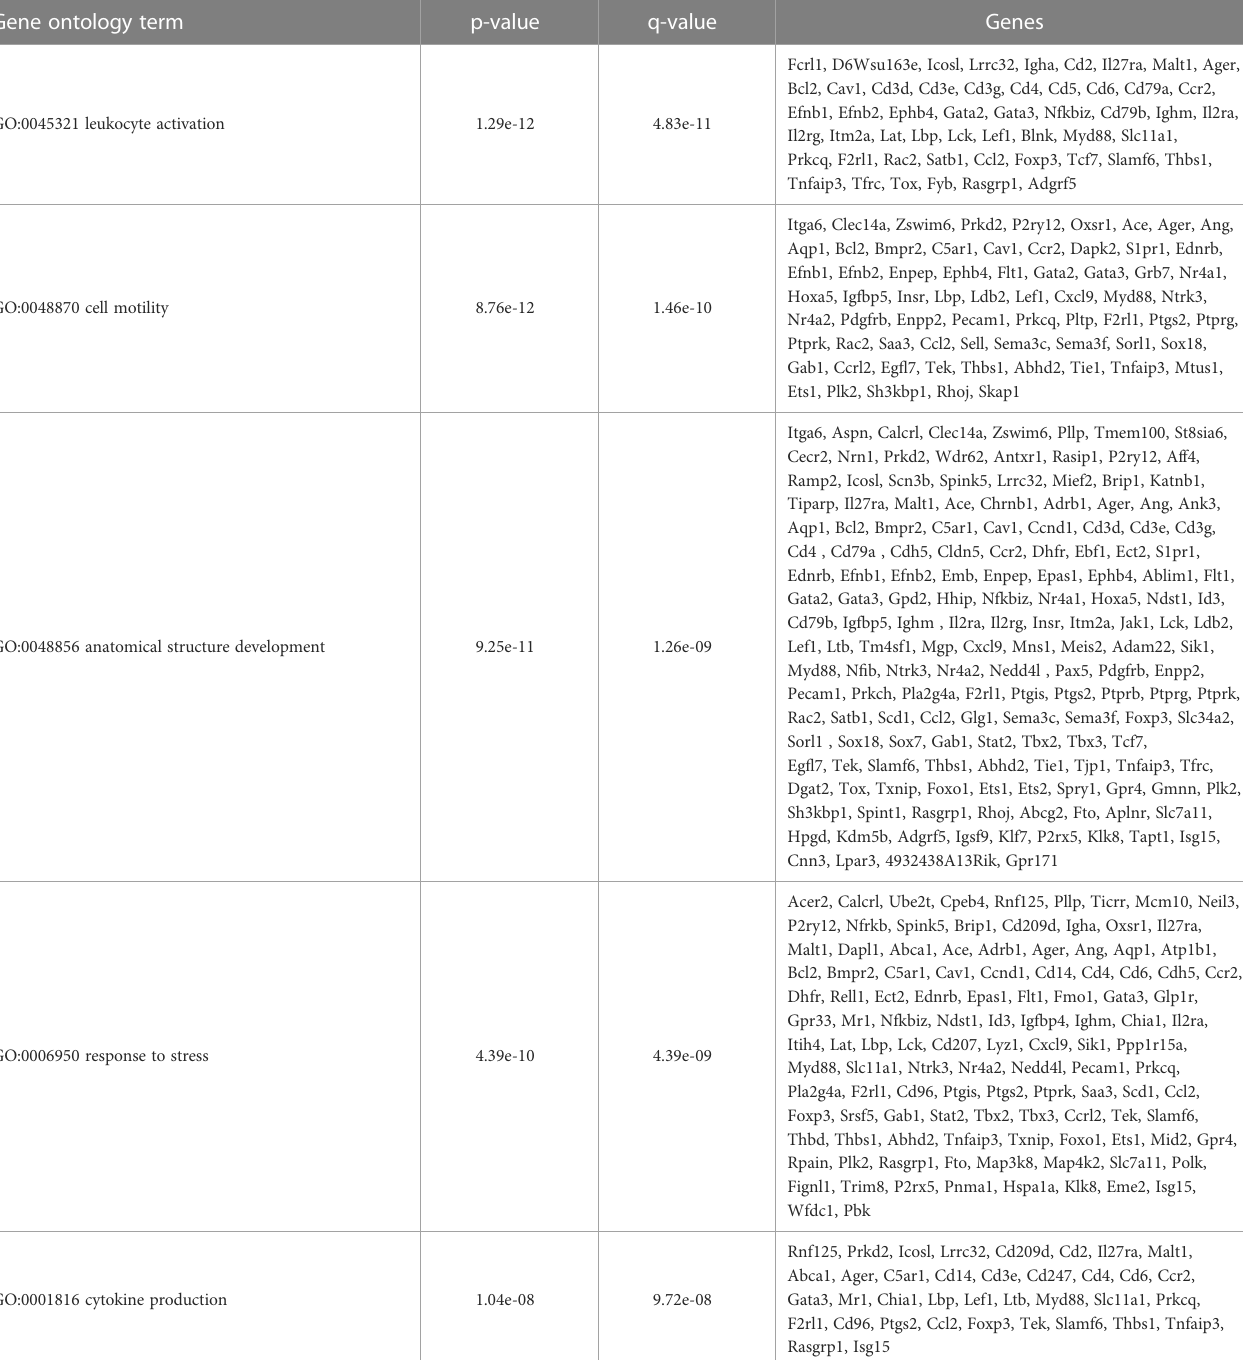
TABLE 3 CD103+ DCs selected overrepresented gene ontology terms. Gene ontology term p-value